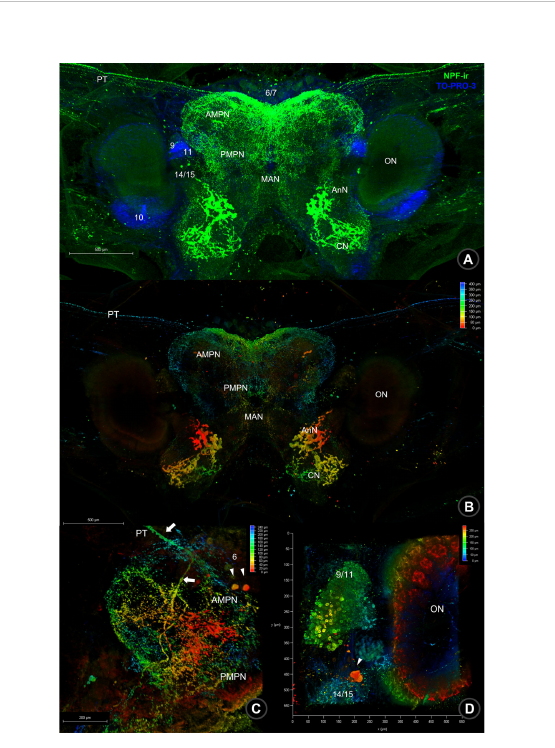
FIGURE 2 Wholemount immuno fl uorescence photographs of Macro -NPF- ir in the brain. (A) The fl uorescence detection of NPF-ir was detected in the whole brain; nuclear staining is presented by TOPRO-3. (B) Depth code photographs of NPF-ir in the whole brain indicated the different plane of localization in neuropils and neurons. (C) Depth code photograph of NPF-ir localized in neuroplis, including AMPN, PMPN, nerve fi ber (PT) connecting to the ES, and neurons in cluster 6. (D) NPF-ir presented in the ON and neurons in cluster 9/11 of the deutocerebrum and clusters